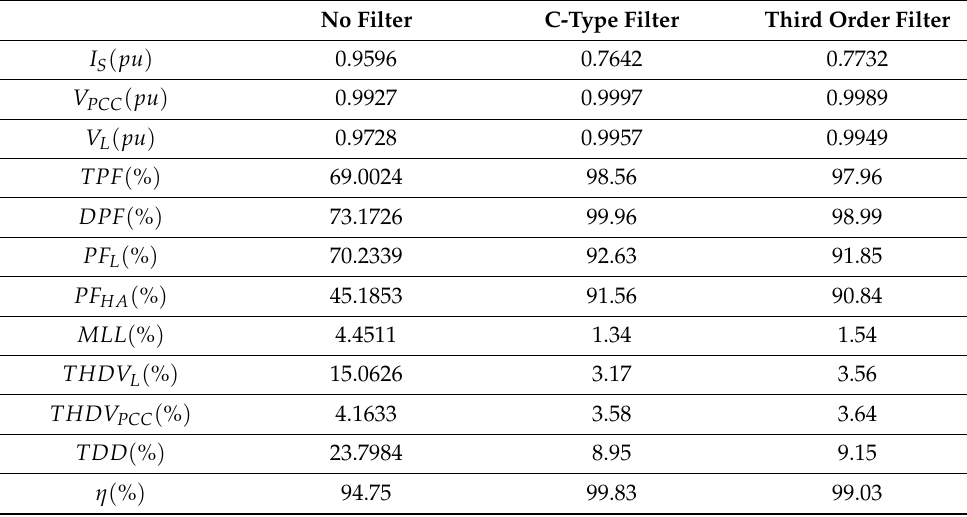
Table 8. Impact on the designed filter on the system performance. No Filter C-Type